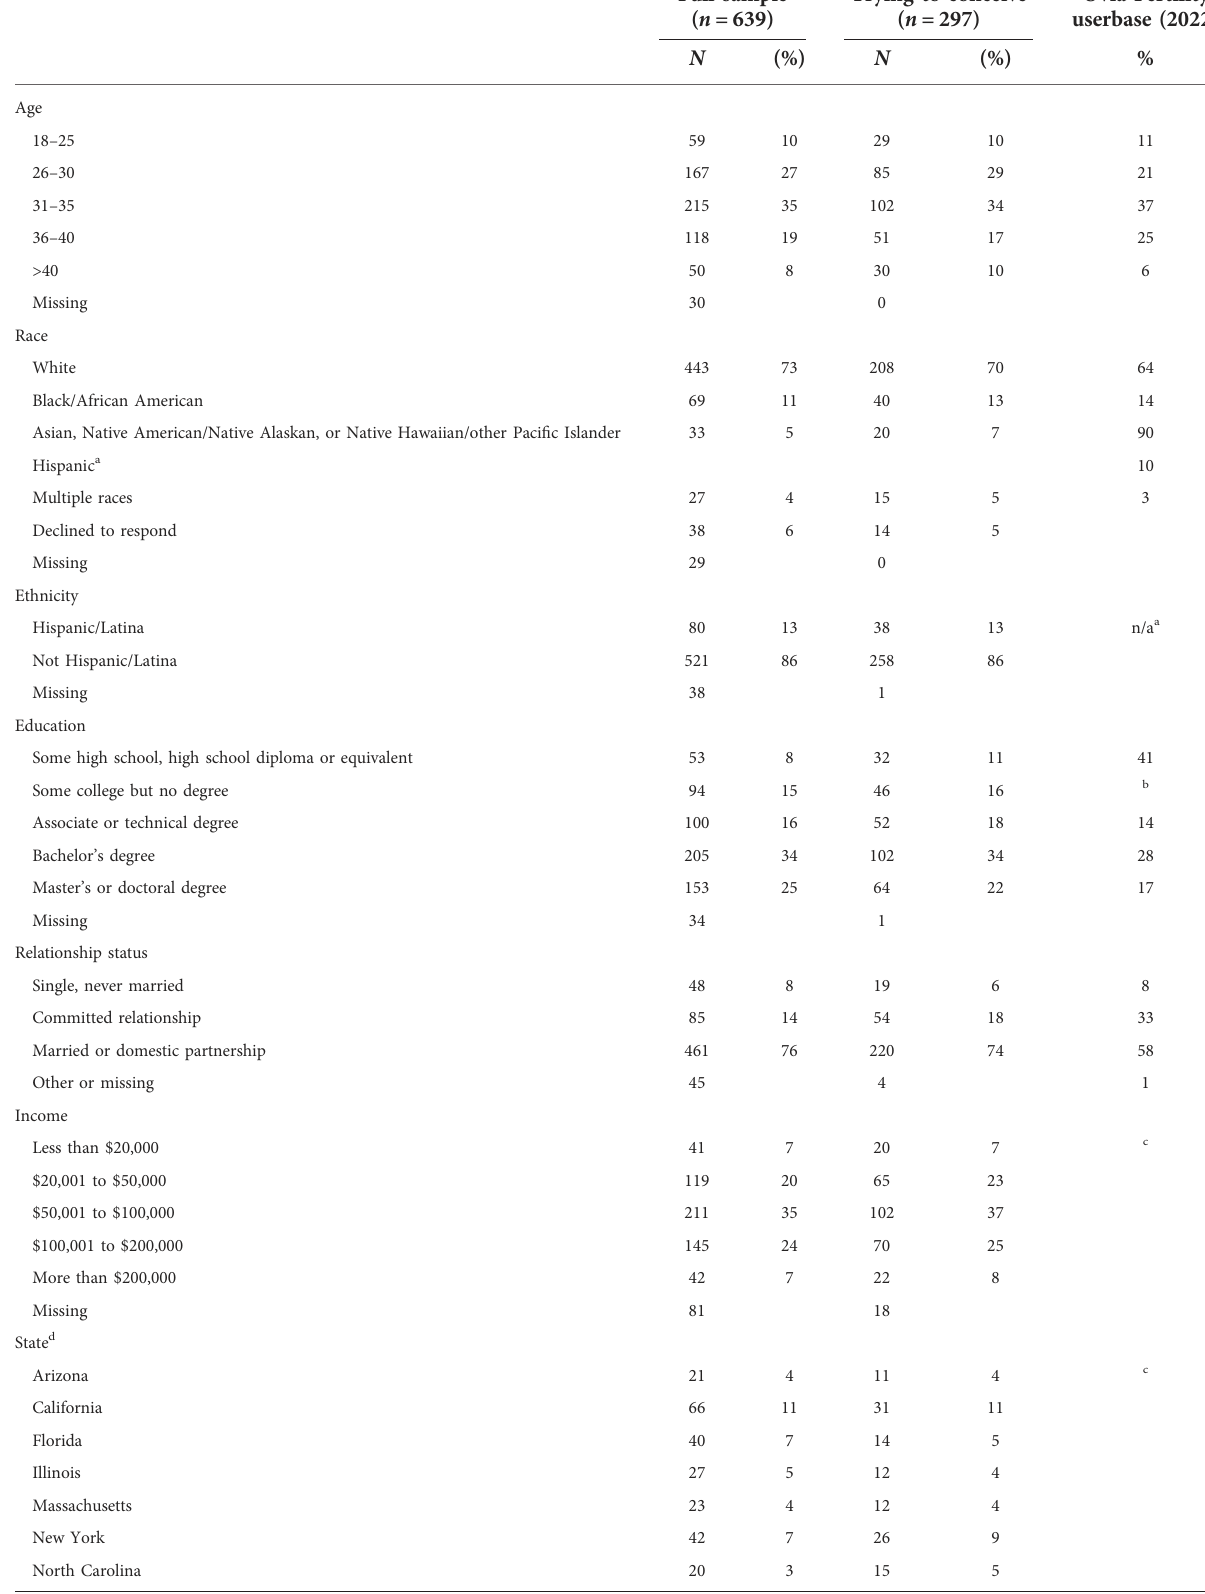
TABLE 1 Demographics of all survey respondents compared with respondents who were trying to conceive, and the Ovia Fertility U.S.